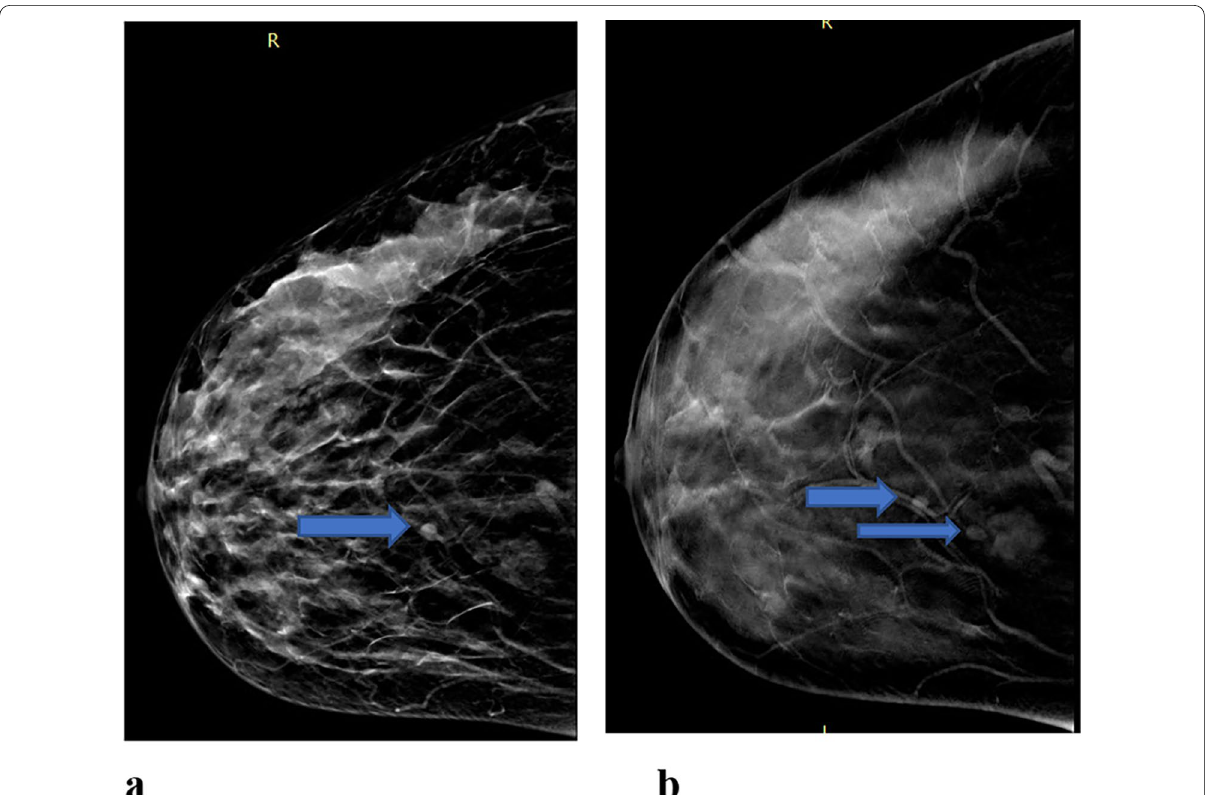
Fig. 3 A 49-year-old female came for follow-up after left breast lumpectomy followed by Chemotherapy and Radiotherapy. a CC view of 2DDM of right breast shows heterogeneously dense breast (ACR c), circumscribed oval dense mass in inner quadrant. b CC view DBT of right breast